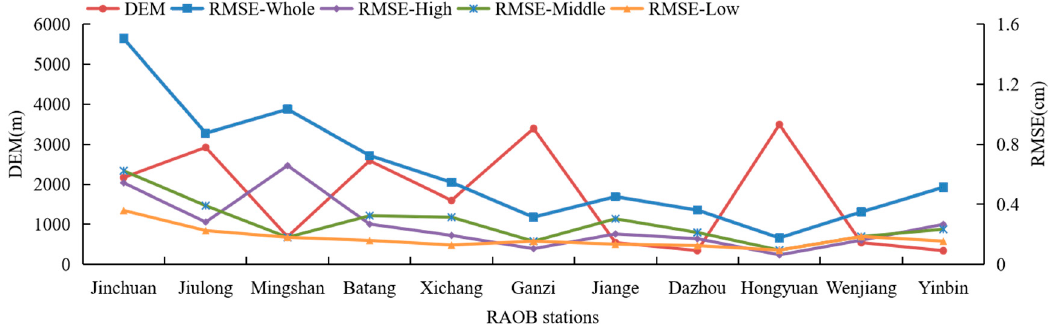
Figure 8. Statistics of the RMSE and DEM from each RAOB station.